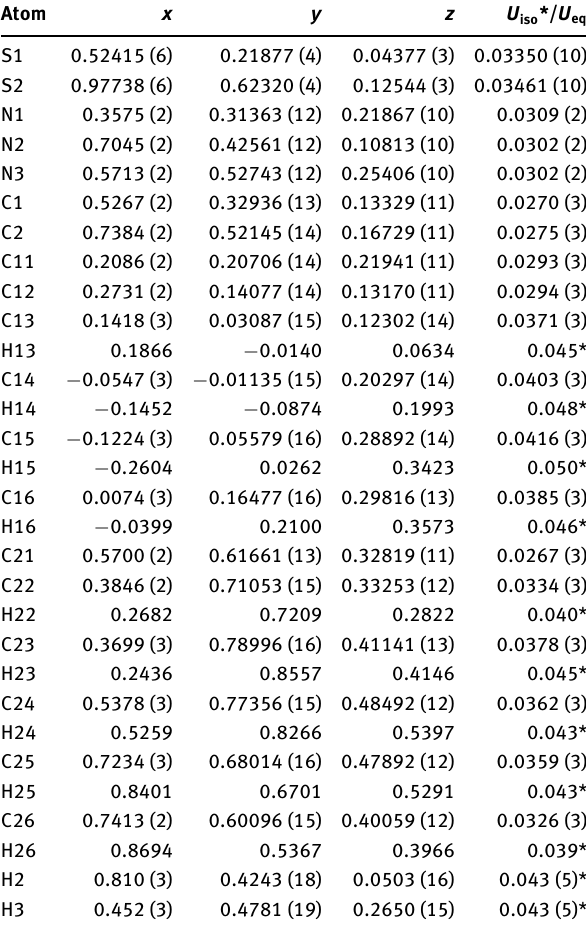
Table 2: Fractional atomic coordinates and isotropic or equivalent isotropic displacement parameters (Å 2 )